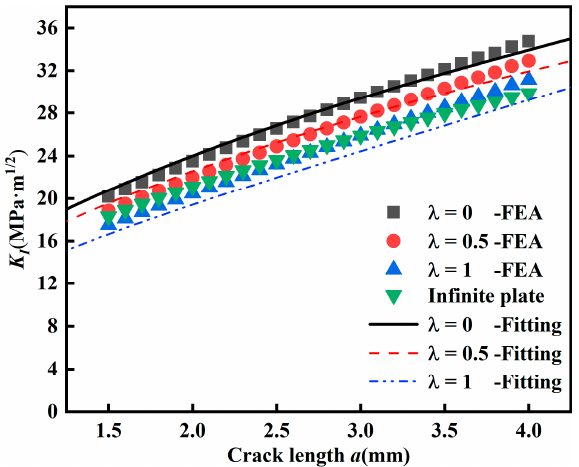
Figure 4. Relationship of K I with crack length a.